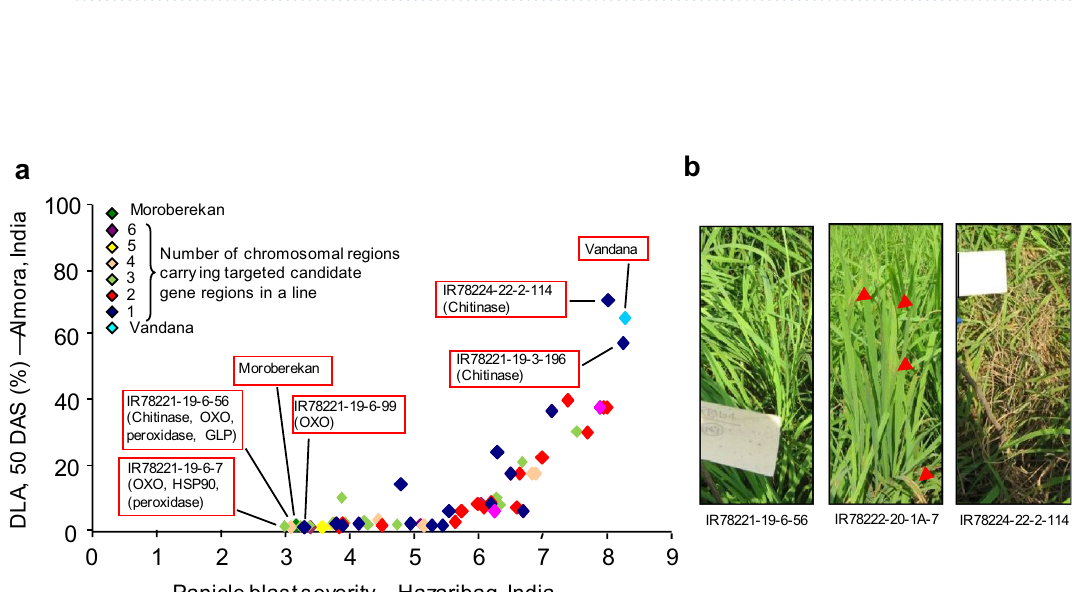
Figure 4. ( a ) Performance of F 6 intermated lines with different number and candidate gene combinations (highlighted in red boxes) in Almora and Hazaribag, India. DLA disease leaf area, DAS days after sowing. ( b ) Leaf blast field phenotypes in Almora. Left: IR78221-19-6-56 (R); center: IR78222-20-1A-7 (S); right: IR78224- 22-2-114 (HS). (R) Resistant; (S) Susceptible; (HS) Highly susceptible. Red arrowhead = blast